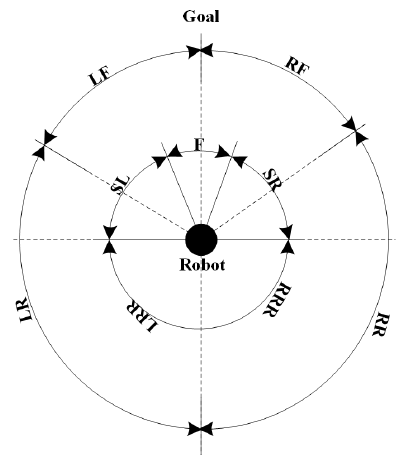
Figure 4. FSH used to derive the membership function for input θ dif f